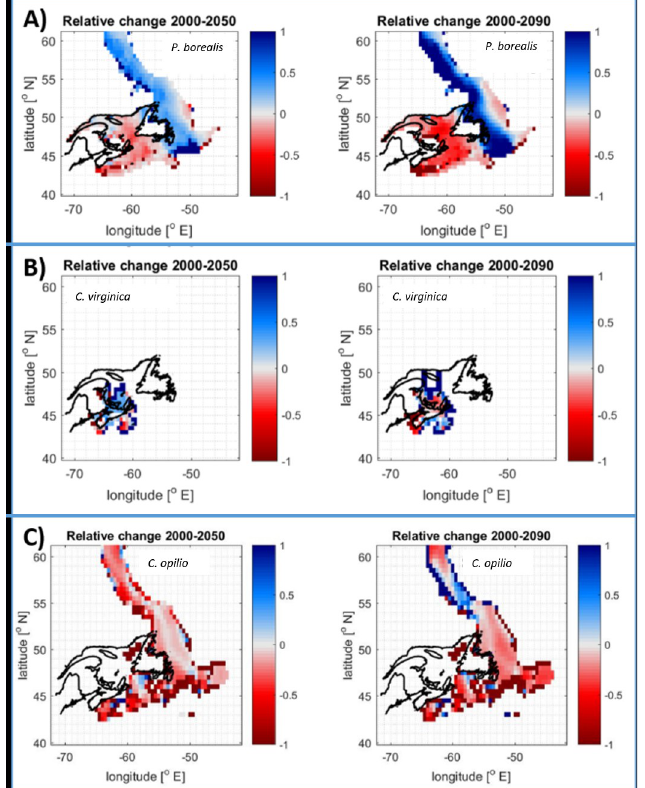
Fig 8. Relative changes in distribution for selected commercially targeted shellfish species. Northern shrimp (a -top), American oyster (b—middle) and snow crab (c—bottom), for 2050 (left) and 2090 (right) under RCP 8.5, highlighting south to north trend of changing species distributions. Colour scales indicate relative change predicted by DBEM for each half-degree latitude by half-degree longitude cell and do not indicate absolute values. Darkest shades (in both directions) correspond to cells with low absolute values, where small absolute changes result in large relative changes (e.g., a shift of 1T to 2T results in a 100% increase, while a change of 10T to 15T only leads to a 50% increase). Changes that exceeded +100% were set to 100% to maintain coherent colour scales. See S1 Fig for baseline DBEM distributions and figures for other species and climate